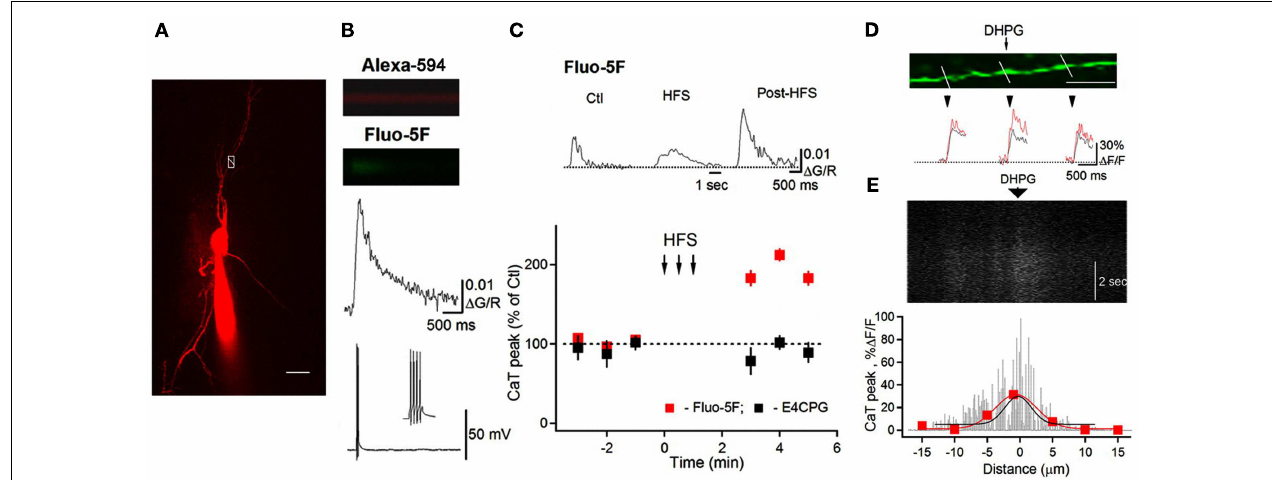
antagonist E4CPG. (D) Magnified image of a dendrite with lines indicating locations for bAP–CaT measurements. Scale bar, 10 µ m.Traces below show bAP–CaTs obtained from these locations in control (black) and after DHPG application (100 µ M; red). (E) Line scan image collected along the middle part of the dendrite shown in (D) and demonstrating a slow DHPG Ca 2 + response with corresponding spatial profile histogram (black fit). For comparison, the spatial profile of potentiated bAP–CaT (red) obtained from this region is shown superimposed. Modified fromTopolnik et al. (2009) with